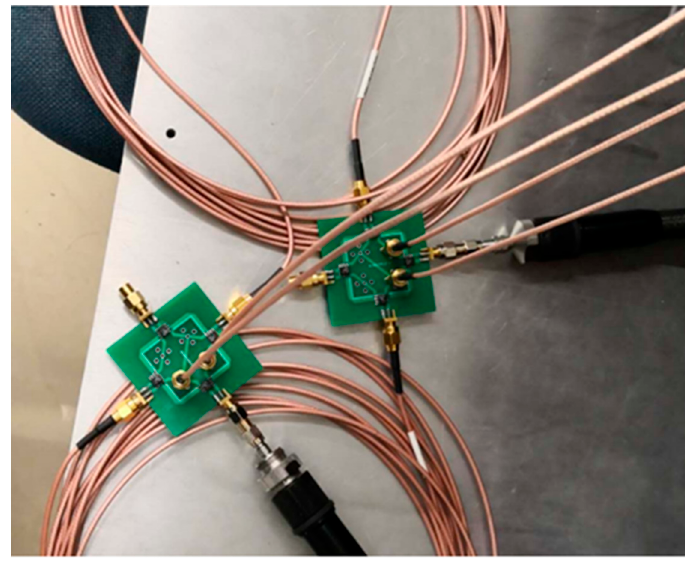
Figure 9. The prototype of the STI.